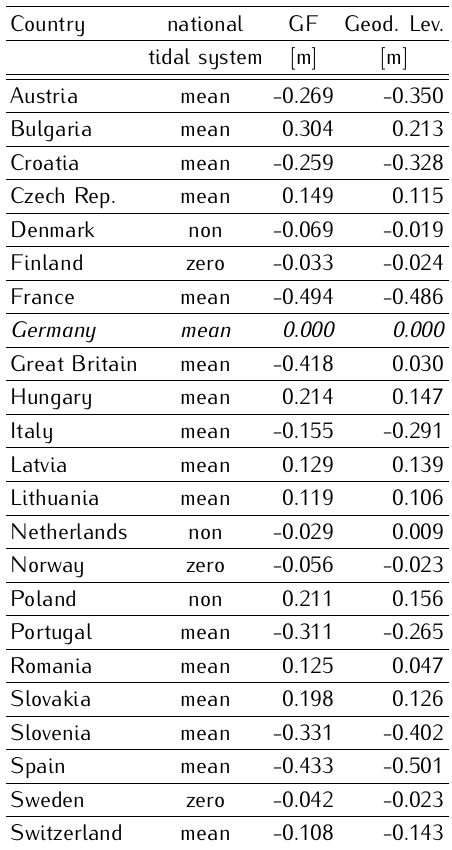
Table 4. Height reference frame unification in Europe: Estimated offsets from GF approach based on the filter-combined GOCO03S+EGG2008 model and geodetic leveling ap- proach. All offsets are given in the national tidal system and have been reduced by the corresponding German value.